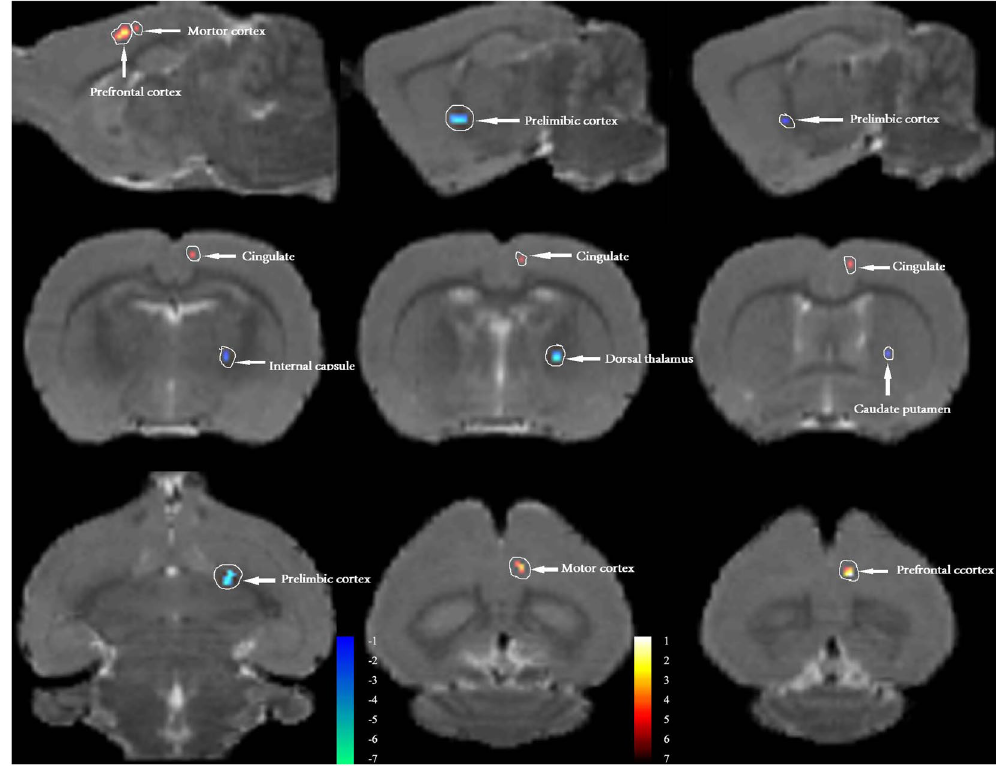
Figure 5. PAG based functional connectivity (FC) in rats induced by dural inflammatory stimulation and in matched controls (day 21). Contrast analysis of the FC differences between the IS group and the Control group revealed significantly increased FC (in red) and decreased FC (in blue) with the PAG in the IS group. Details of the clusters shown are reported in Table. IS, inflammatory soup; PAG, periaqueductal